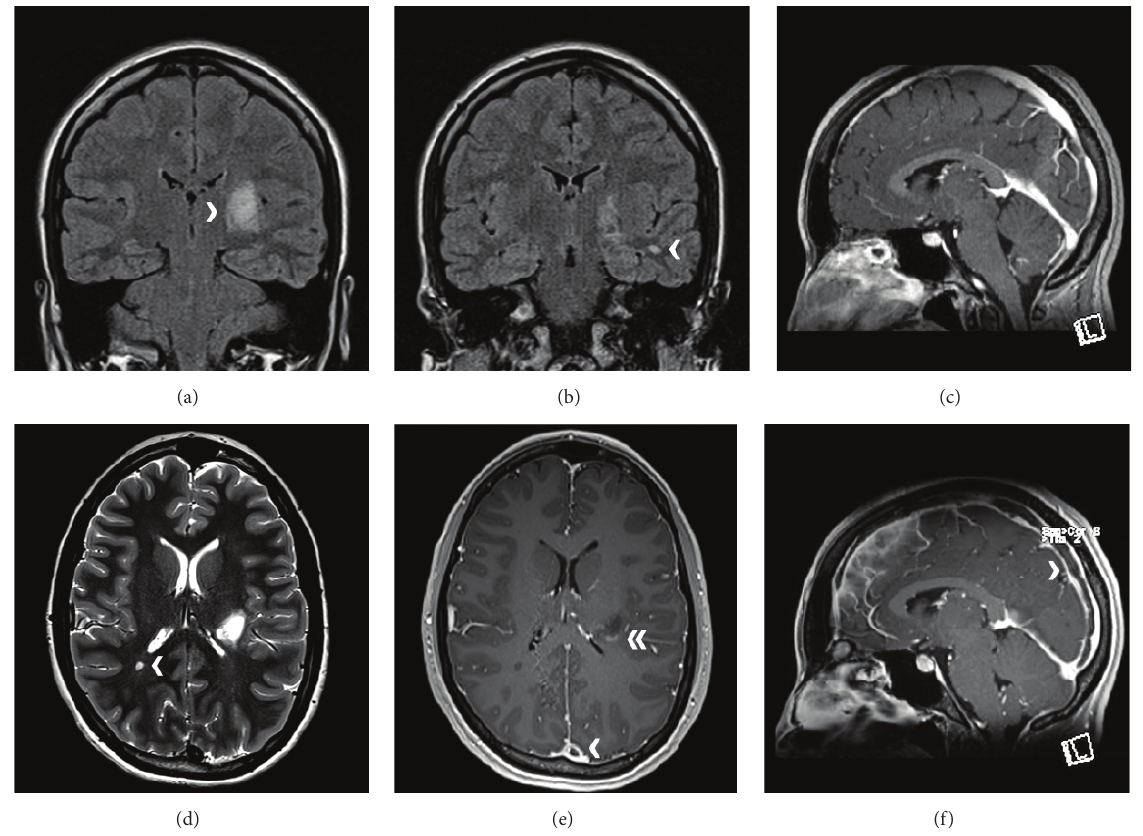
Figure 1: The magnetic resonance imaging of the patient reveals a large hyperintense lesion on FLAIR (a) and T2 (d) in the posterior limb of the left-sided internal capsule, probably extending to the thalamus. The other supratentorial lesions are much smaller (in the right occipital (d) and left temporal white matter ((b) FLAIR)). In the initial imaging the blood flow in the sagittal sinus was free ((c) gadolinium (Gd) enhanced T1w). 8 days later the white matter lesions were unchanged ((d) T2w, arrowhead pointing out a small lesion behind the occipital horn of the right ventricle) and some lesions were still Gd enhancing ((e) double arrowhead, Gd enhanced T1w). But now a thrombosis of the superior sagittal sinus can be seen ((e), (f) arrowheads, Gd enhanced T1w).